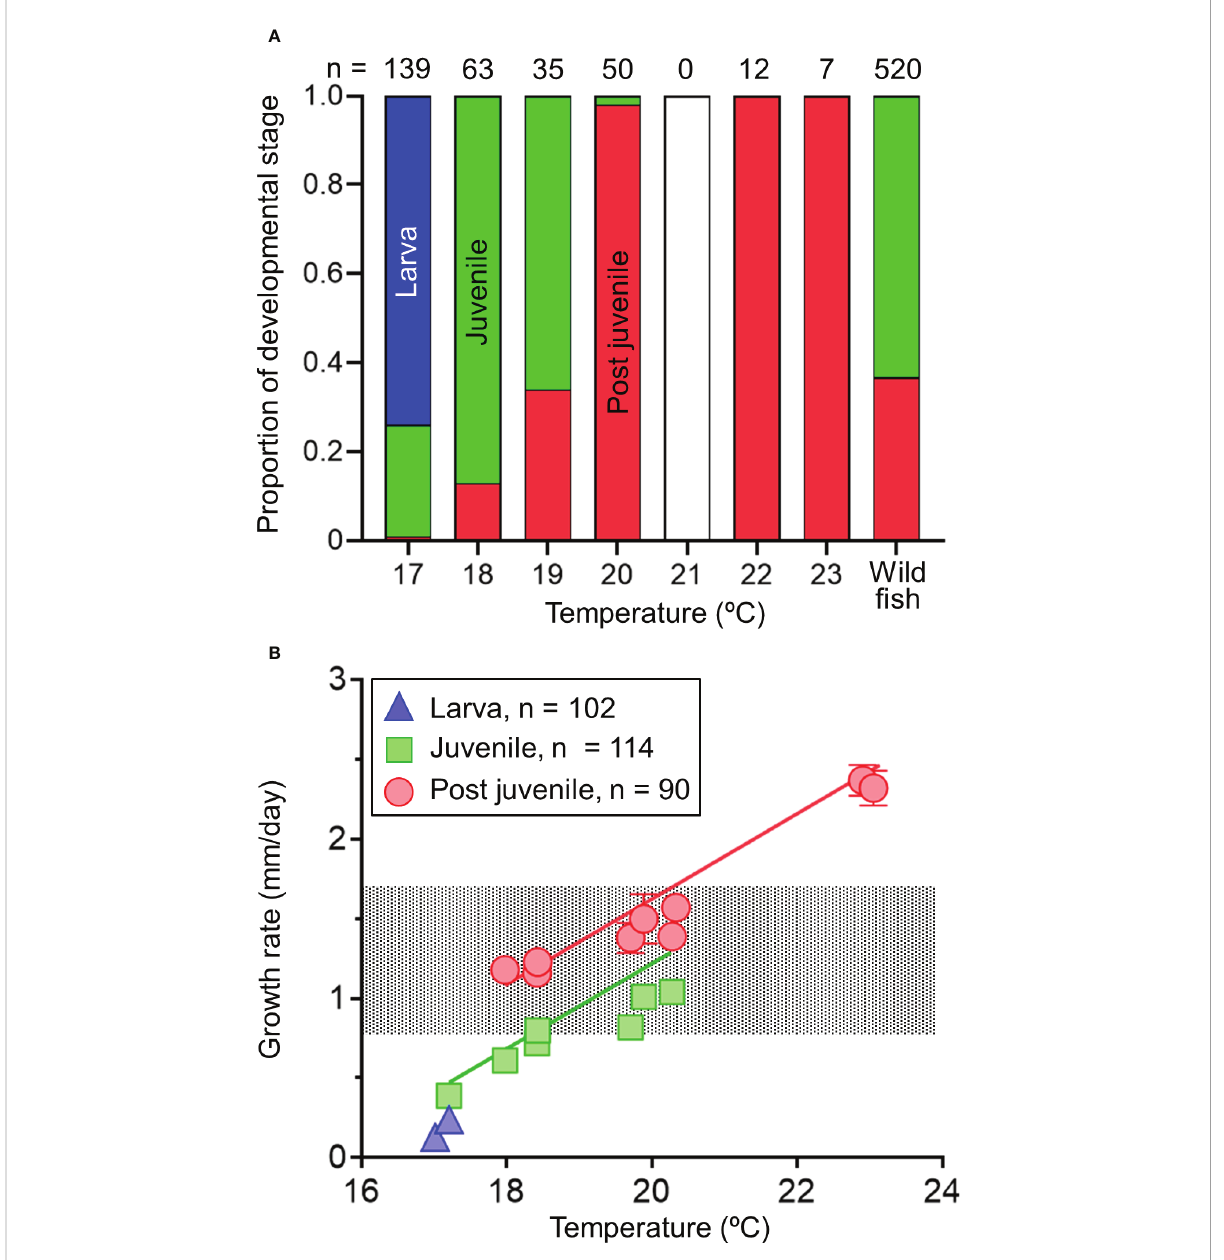
FIGURE 8 Relationships between the proportion of developmental stage and temperature (A) of 25-day-old chub mackerels and growth rate (mm/day) and temperature (B) . Specimens were classi fi ed into larval (blue), juvenile (green), and post juvenile (red) stages. Predicted lines using the linear mixed effect models fi tted to the observed data in different stages (straight lines) and the range of 5 – 95 percentiles of growth rates of wild fi sh collected in 2002 – 2011 (dotted area) are shown (B) . Data are shown as mean ± SE (B) . The proportion of developmental stage in the wild fi sh estimated from the growth rate until age 25 days is also shown (A) . Numbers indicate sample